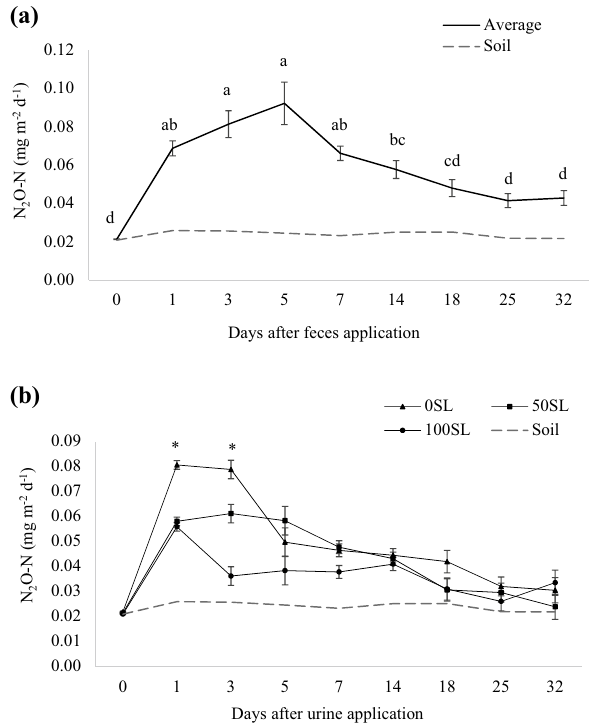
Figure 1. Net flux of N 2 O emitted by ( a ) feces from beef steers fed sericea lespedeza [SL; Lespedeza cuneata (Dum. Cours.) G. Don], where values represent the average of three diets (0, 50 or 100% SL) in two experimental periods, and means followed by different letters are significantly different among sampling days ( P day < 0.001); and ( b ) urine collected from beef steers fed 0SL, 50SL or 100SL, where asterisk indicates differences among diets within day ( P SL*Day < 0.001). Bars refer to standard deviation. Dashed line represents soil (no excreta)